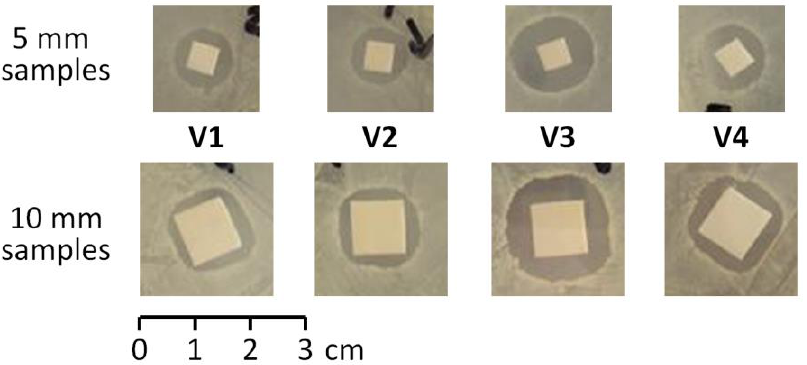
Figure 10. Inhibition of St. aureus by V1 – V4 film samples during Kirby – Bauer disk diffusion tests (24 h incubation at 37 °C). The sample V3 demonstrated maximum effect. Table 4. Inhibition of St. aureus by V1 – V4 film samples (by diameter of transparent area, mm). Exp.